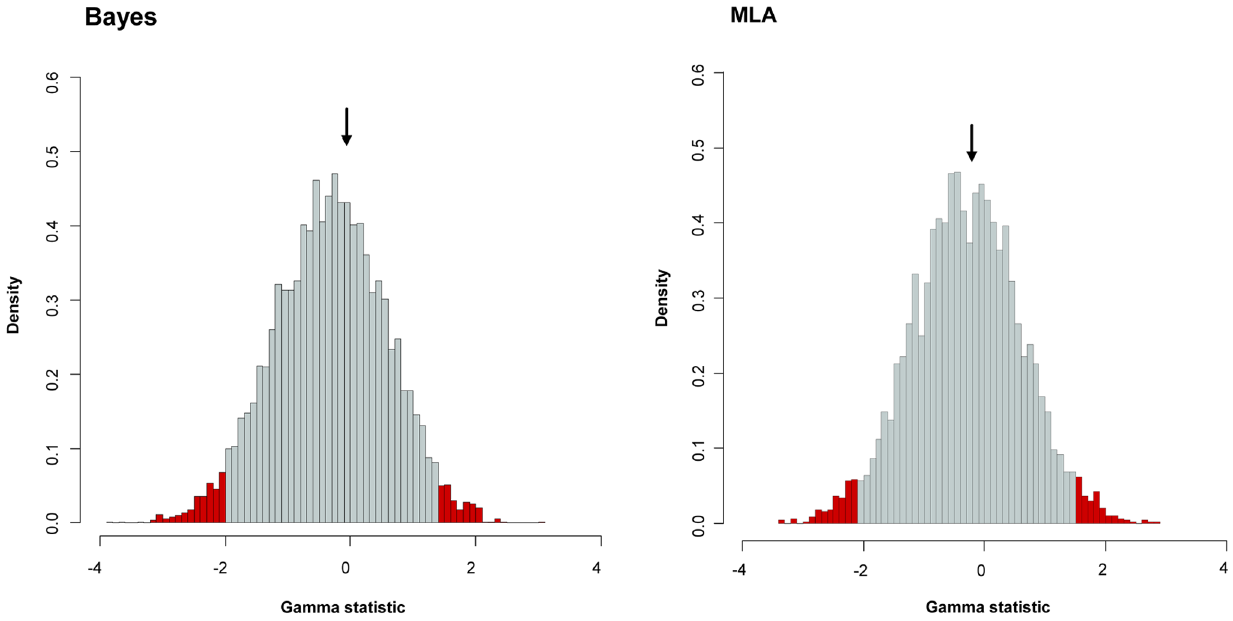
Figure 7. Gamma statistic distribution. Gamma statistic distribution was obtained by simulating 5,000 phylogenies under a Yule model using Bayes (left) and MLA (right) approaches. The arrows indicate the gamma value obtained from our sequences. Red bars indicate the 95% limits of the distribution.